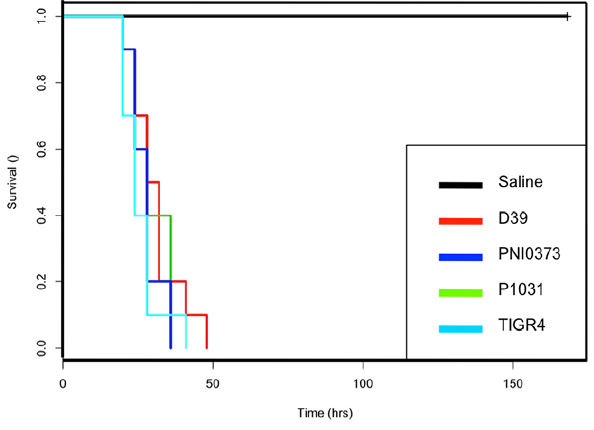
Figure 1. Murine survival following intraperitoneal challenge. Kaplan-Meier survival curves of groups of six female CD-1 mice after intraperitoneal challenge with TIGR4 ( — (light blue) ), D39 ( — (red) ), P1031( — (green) ), PNI0373 ( —(dark blue) ) and R6/saline alone ( — (black) ).